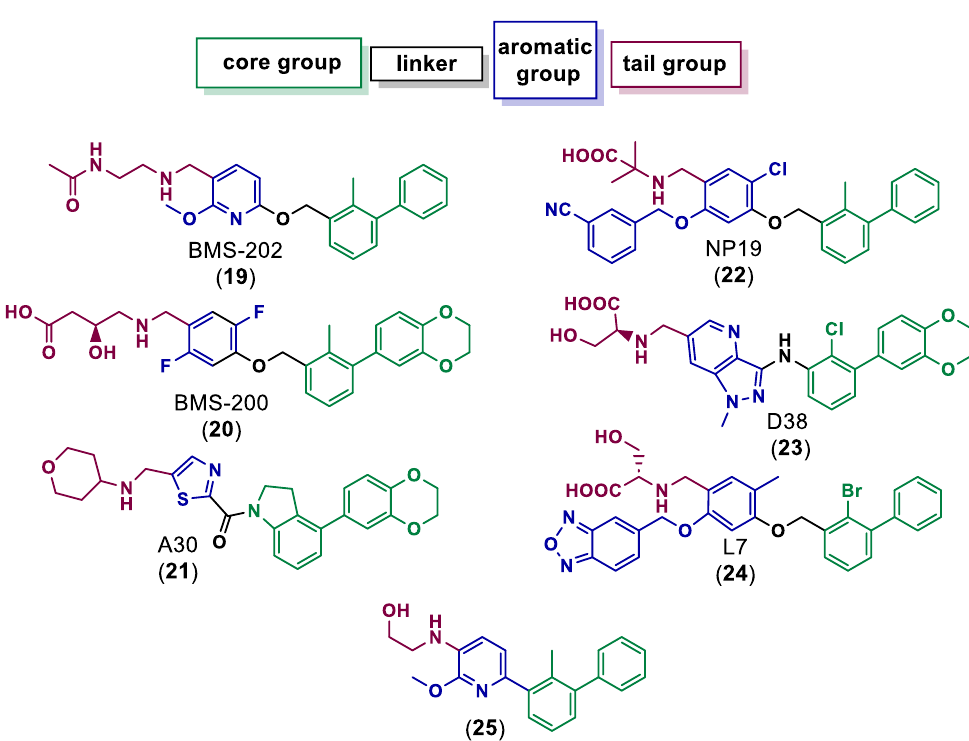
Figure 5. Small molecule inhibitors of PD-1/PD-L1 based on the BMS pharmacophoric model [59,61,62,74–76].